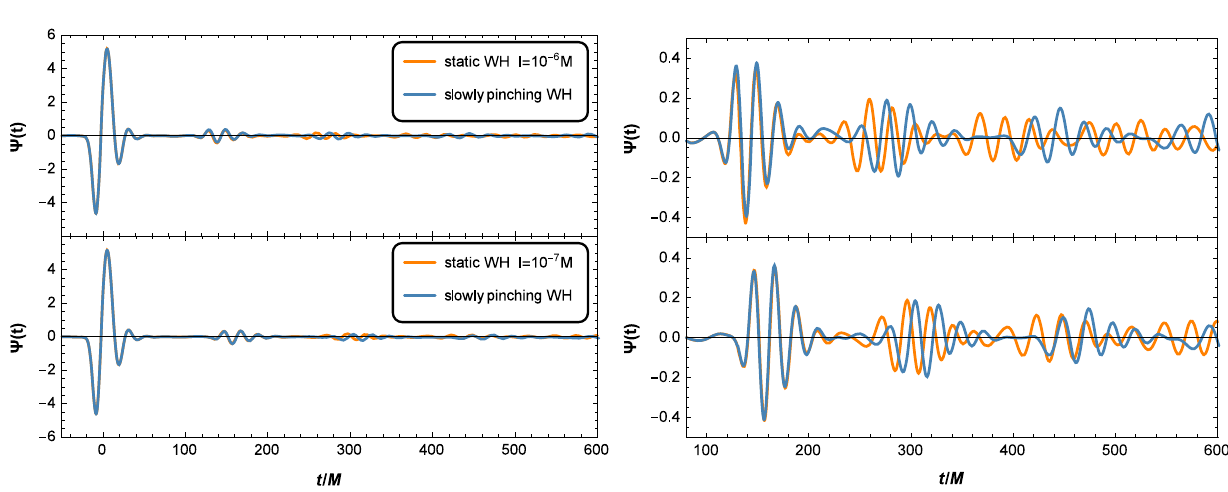
Fig. 2 Ringdown waveforms of post-merger objects, which correspond to the static and slowly pinching WHs (depicted by Fig. 1), respectively. The right panel is equivalent to the left panel in the segment 100 (cid:4) t / M (cid:4)